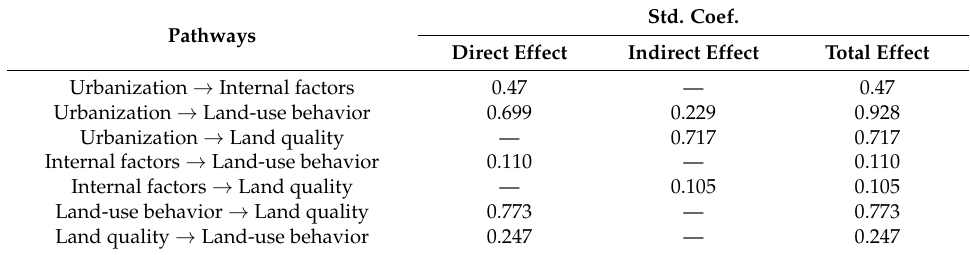
Table 3. Standardized direct, indirect and total effects between latent